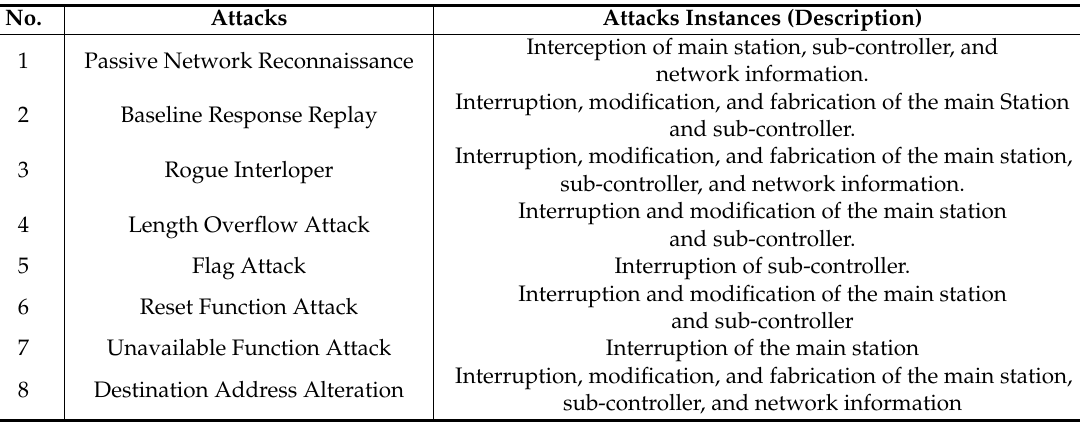
Table 2. Attack taxonomy for the DNP3 data link